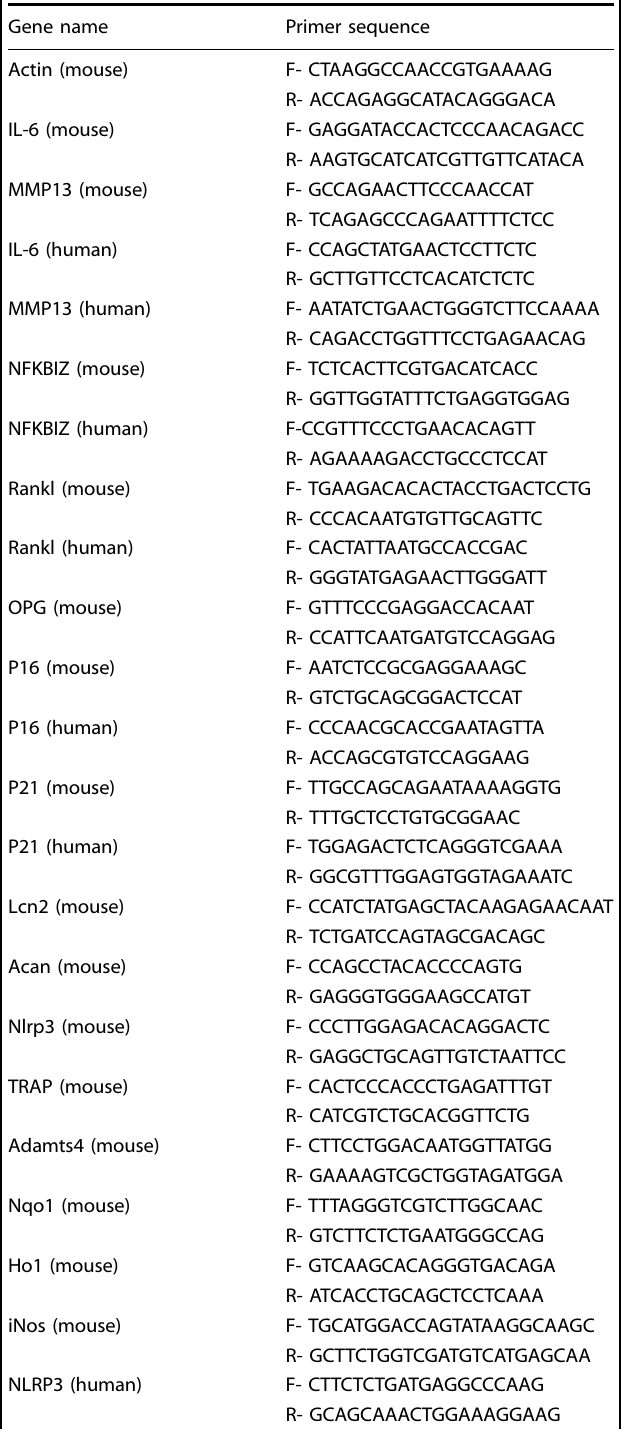
Table 2. List of primers used in this